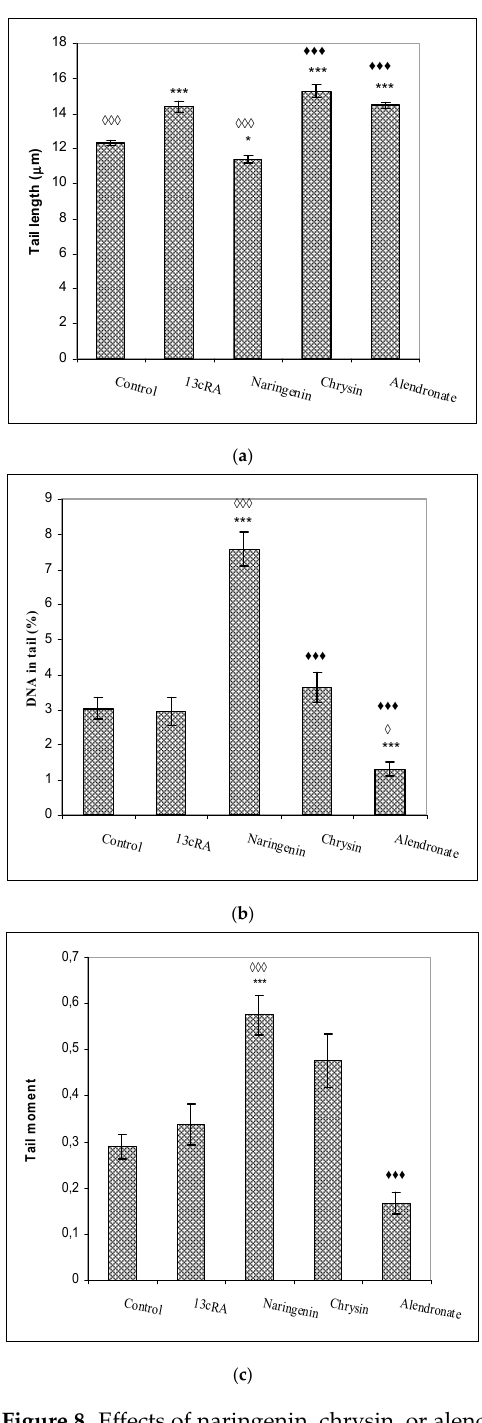
Figure 8. Effects of naringenin, chrysin, or alendronate on comet assay parameters (tail length ( a ), DNA in tail ( b ), and tail moment ( c )) of peripheral blood cells in rats with retinoic-acid-induced osteoporosis. Rats were administered ig with retinoic acid (13cRA) suspension (80 mg/kg) once daily for 14 days. After inducing osteoporosis with 13cRA, rats were administered ig with naringenin (100 mg/kg), chrysin (100 mg/kg), or alendronate (40 mg/kg), once daily for the next 14 days. Number of rats per group: 7. Data were analysed by the Kruskal–Wallis test. *—Statistically ♦ significant compared with control (* p < 0.05; *** p < 0.001). —Statistically significant compared ♦ p ♦♦♦ p (cid:7) with 13cRA ( < 0.05; < 0.001). —Statistically significant compared with Naringenin (cid:7)(cid:7)(cid:7) p ( <